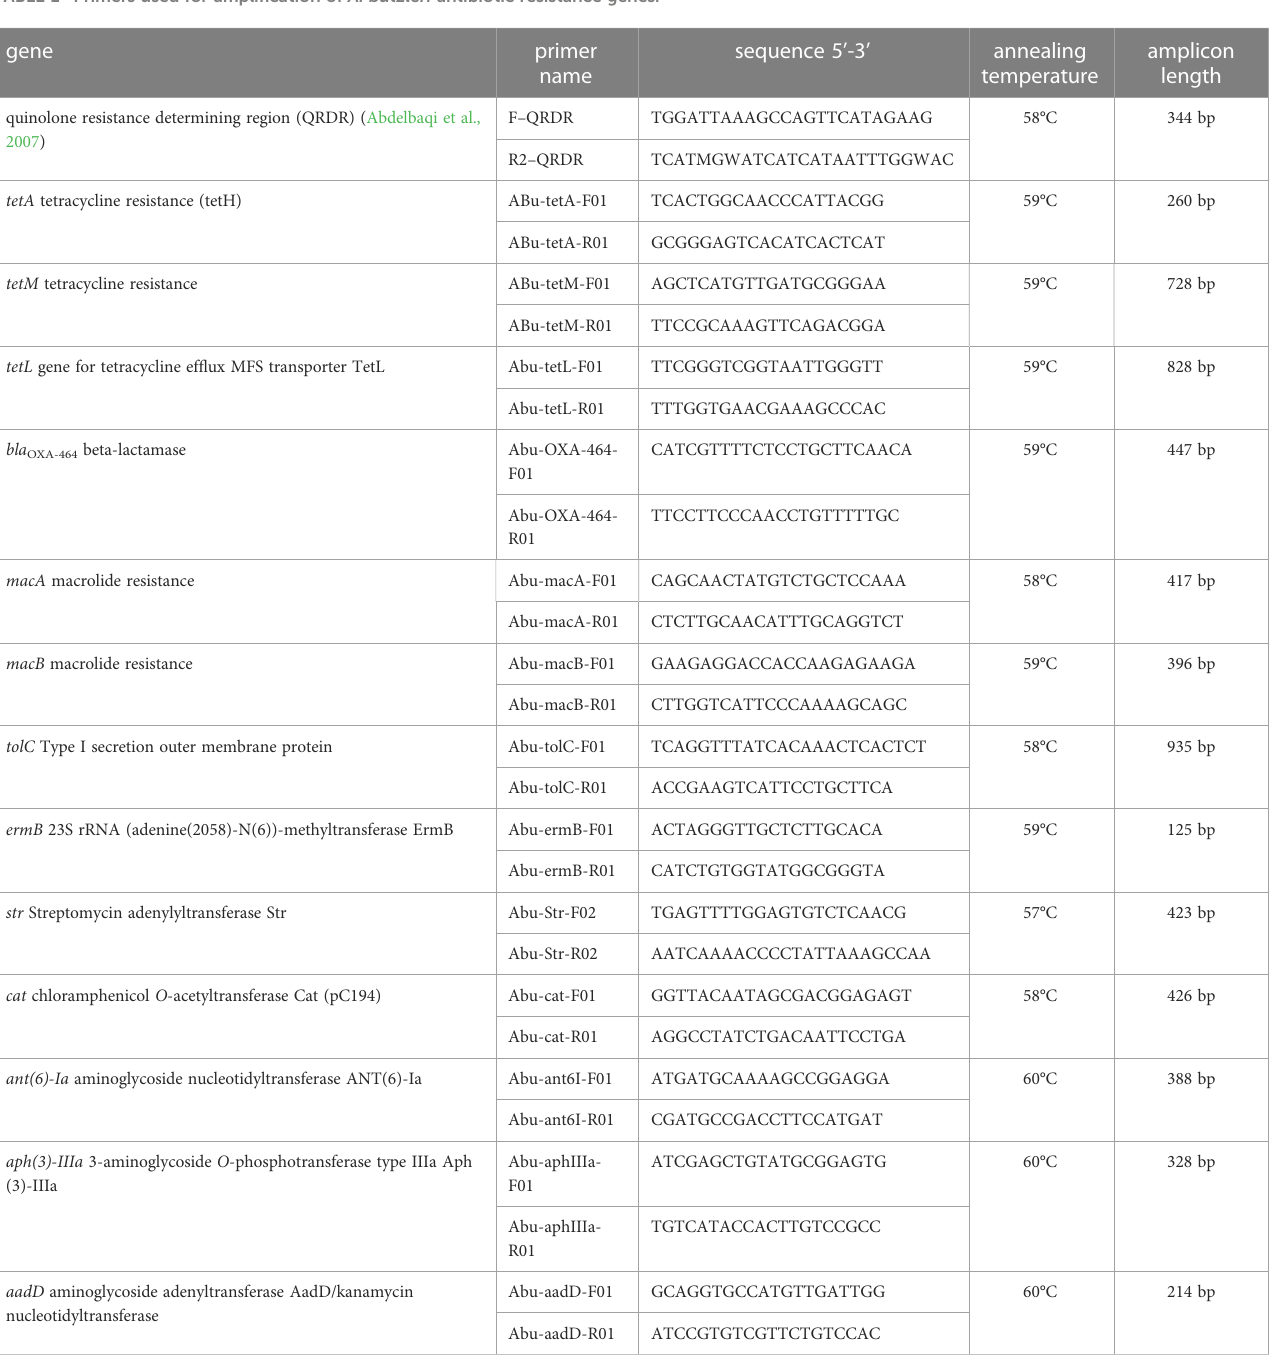
TABLE 1 Primers used for ampli fi cation of A. butzleri antibiotic resistance genes. gene primer